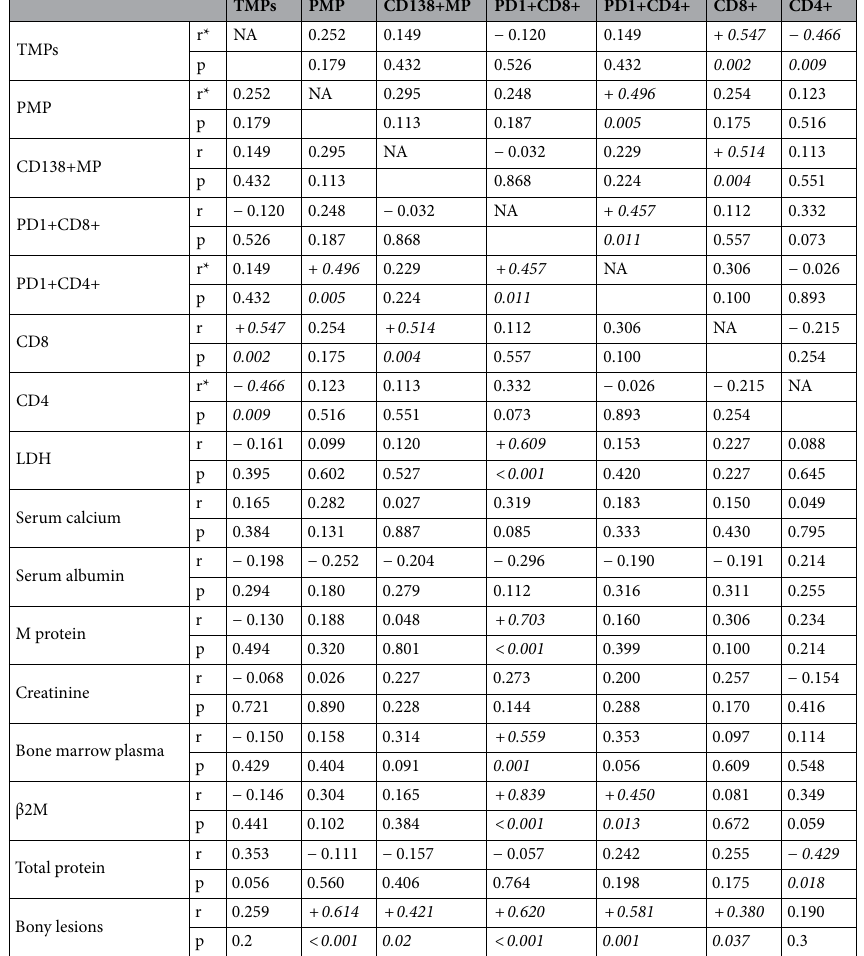
Table 4. Correlations between MPs, PD1, and other prognostic factors of MM. r: Pearson correlation coefficient; r*: Spearman rho correlation coefficient; p: p-value; MP: microparticles; β2M: beta2 microglobulin.